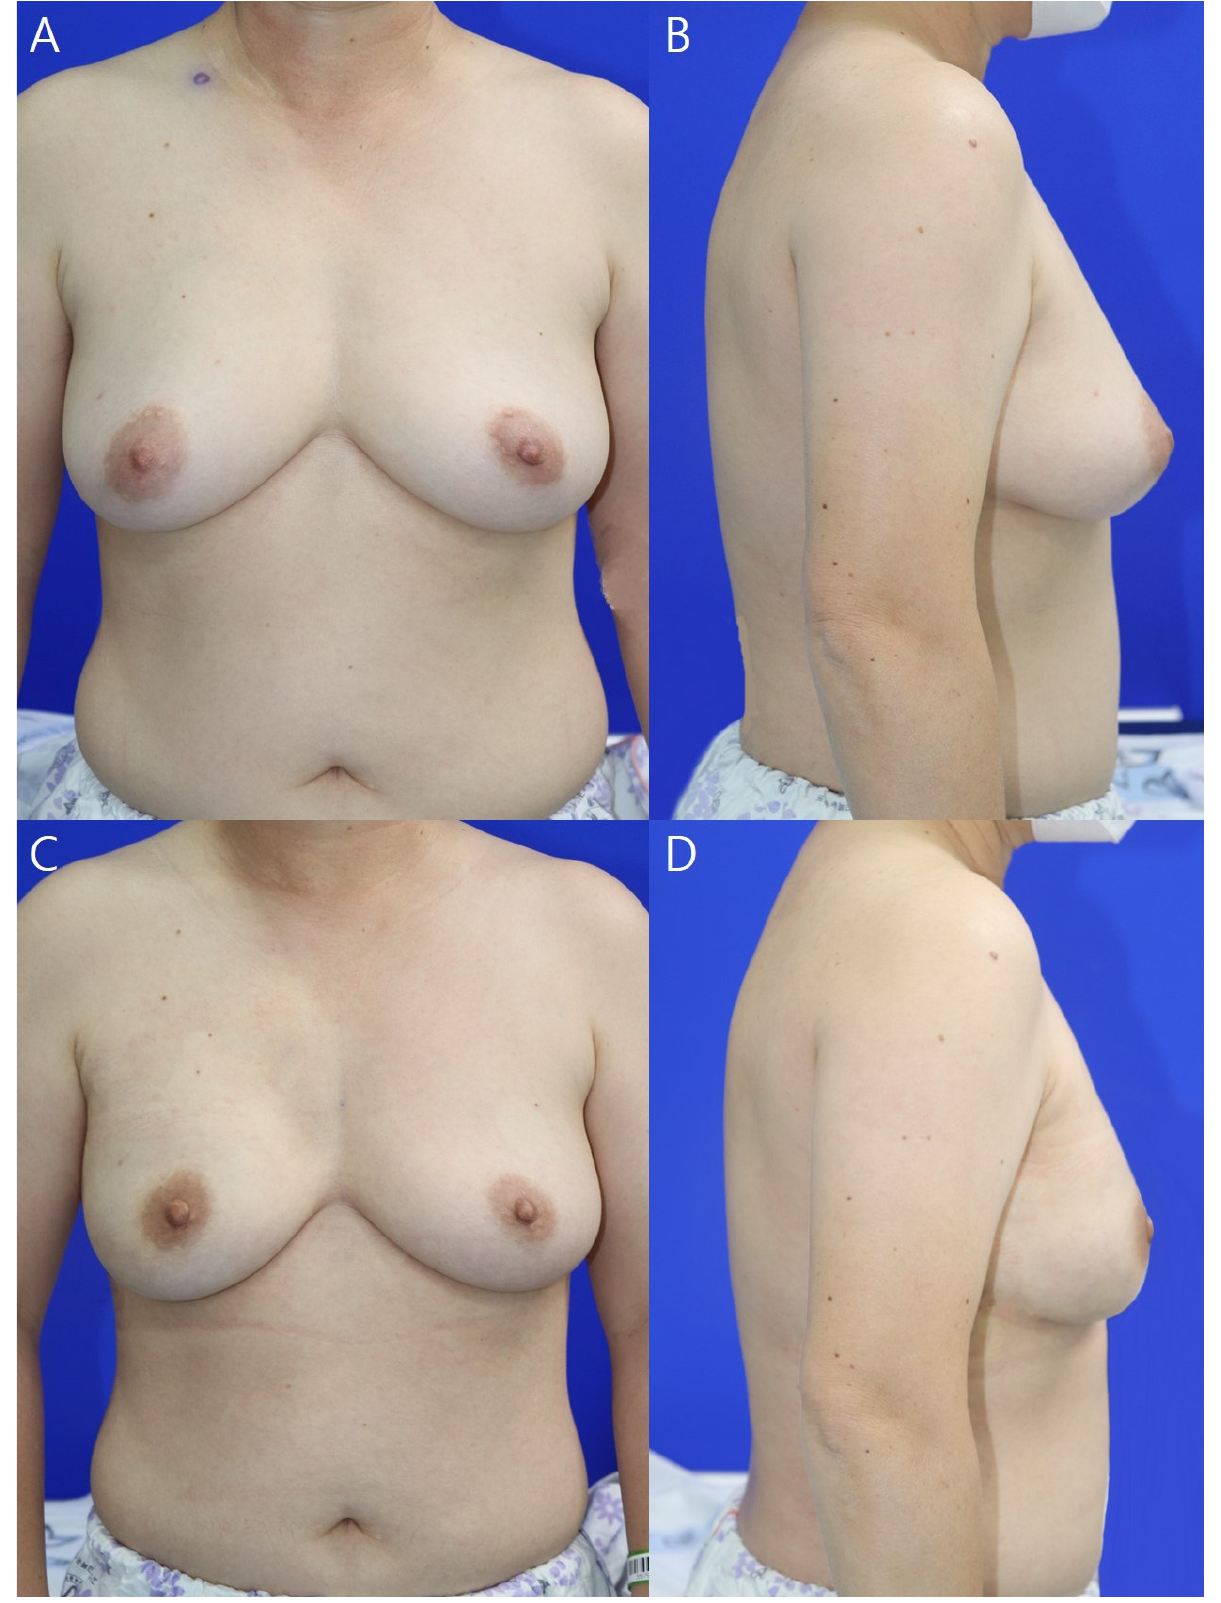
Figure 5. Pre ‐ ( A , B ) and postoperative ( C , D ) 12 ‐ month photographs. This 54 ‐ year ‐ old patient was diagnosed with ductal carcinoma in situ of the right breast; the resected breast tissue weighed 334 g. A 275 ‐ cc breast implant and 18 × 18 cm 2 Bellacell ® acellular dermal matrix were placed inside.